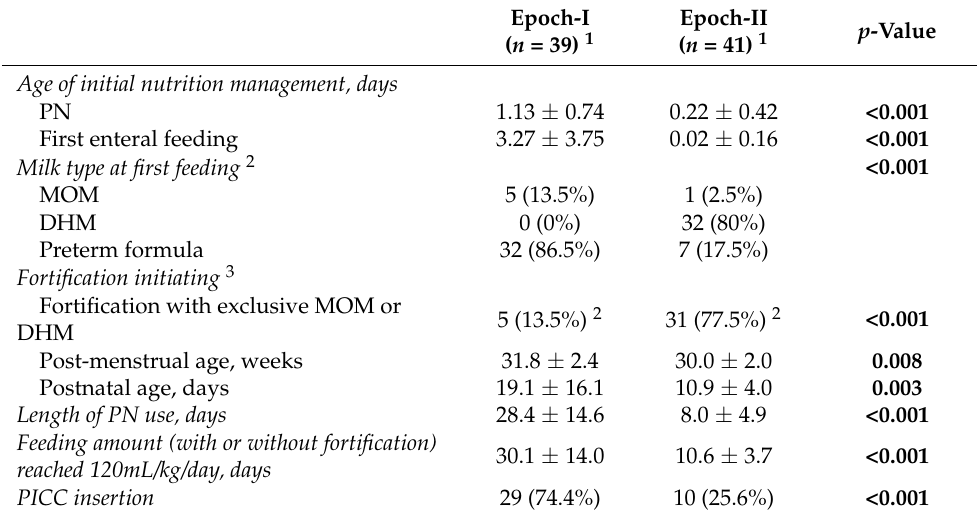
Table A1. Comparison of nutritional practices in two